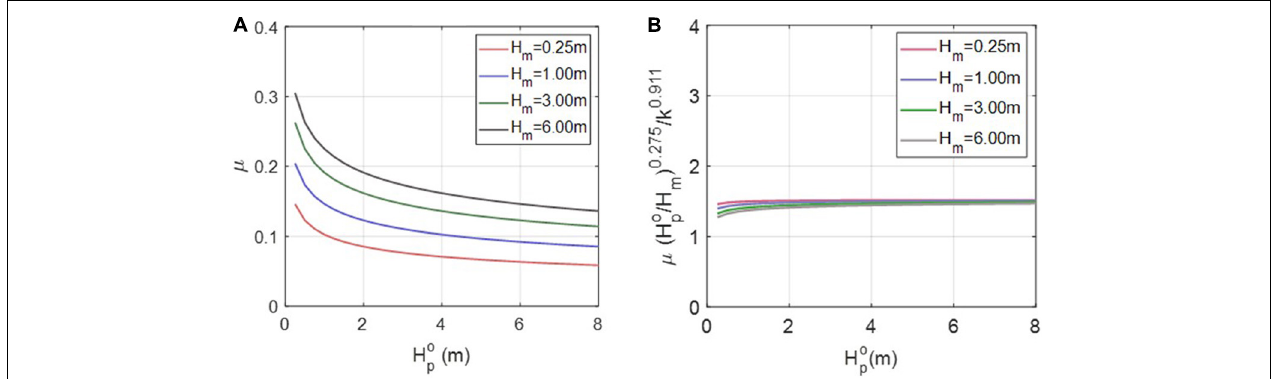
FIGURE 14 | Variation of µ w.r.t H o p ; (A) before scaling with k r = 0 . 08 d − 1 and (B) after